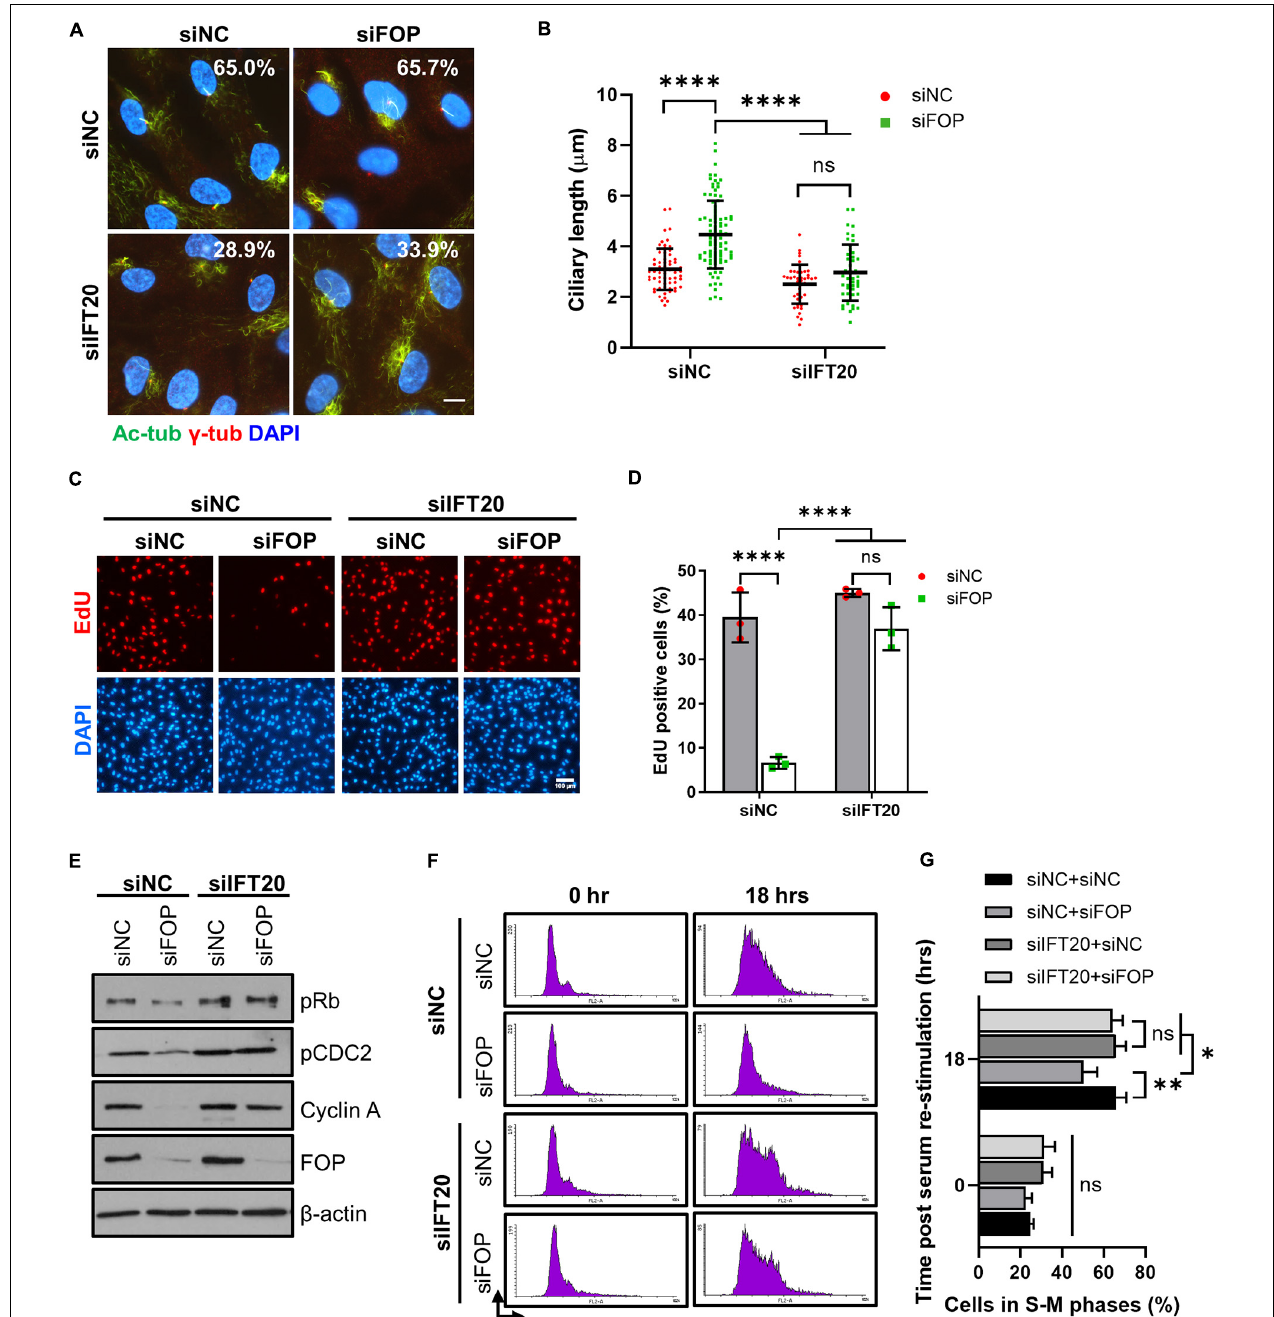
FIGURE 6 | Delay in cell cycle re-entry induced by FOP knockdown is dependent of primary cilia. (A) RPE1 cells transfected with siNC or IFT20 siRNA were further transfected with the negative control siRNA or FOP siRNAs, serum-starved, and immunostained for γ -tubulin ( γ -Tub; red) and acetylated α -tubulin (Ac-Tub; green). The nuclei were stained with DAPI. The percentage of ciliated cells from two independent experiments was indicated in the corresponding image. At least 200 cells per sample were analyzed. Scale bar, 10 µ m. (B) Quantification of ciliary length described in (A) . From left to right, cilia number n = 64, 94, 42, and 45. (C) RPE1 cells were transfected with the indicated siRNAs. Following 48 h of serum-starvation, the cells were serum re-stimulated for 18 h, with cells being labeled with EdU during the final 2 h. The nuclei were stained with DAPI. Scale bar, 100 µ m. (D) Quantification of the percentage of EdU positive cells described in (C) . At least 500 cells per sample were analyzed in each experiment. (E) Immunoblotting analysis of the levels of phosphorylated Rb at Ser807/811 (pRb), phosphorylated CDC2 at Tyr 15 (pCDC2), Cyclin A and FOP in cells transfected with the indicated siRNAs at 18 h post serum re-stimulation. (F) Cell cycle profiles of cells transfected with the indicated siRNAs at 0 and 18 h post serum re-stimulation were determined by flow cytometry. At least 10,000 cells per sample were analyzed in each experiment. (G) Quantification of the percentage of S-M phases cells described in (F) . Data are presented as mean ± SD from three independent experiments; ns, not significant; * p < 0.05; ** p < 0.001; **** p < 0.0001 (Two-way ANOVA followed by Tukey’s multiple comparisons test).